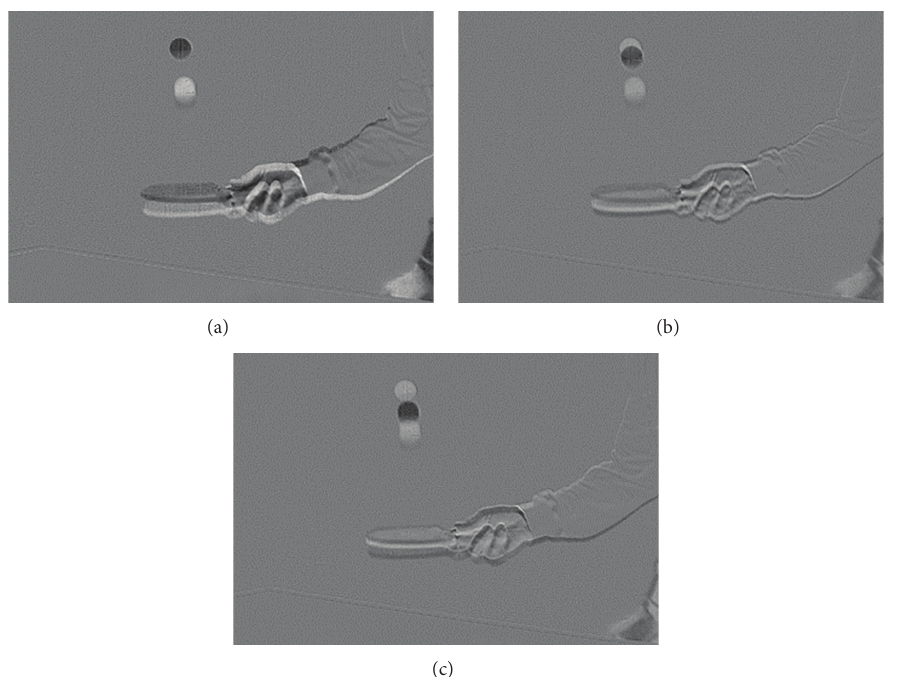
Figure 3: (a) Δ -frame from Frame 4 in 𝑌 band, (b) R-frame from Frame 2 in 𝑌 band, and (c) R-frame from Frame 3 in 𝑌 band.